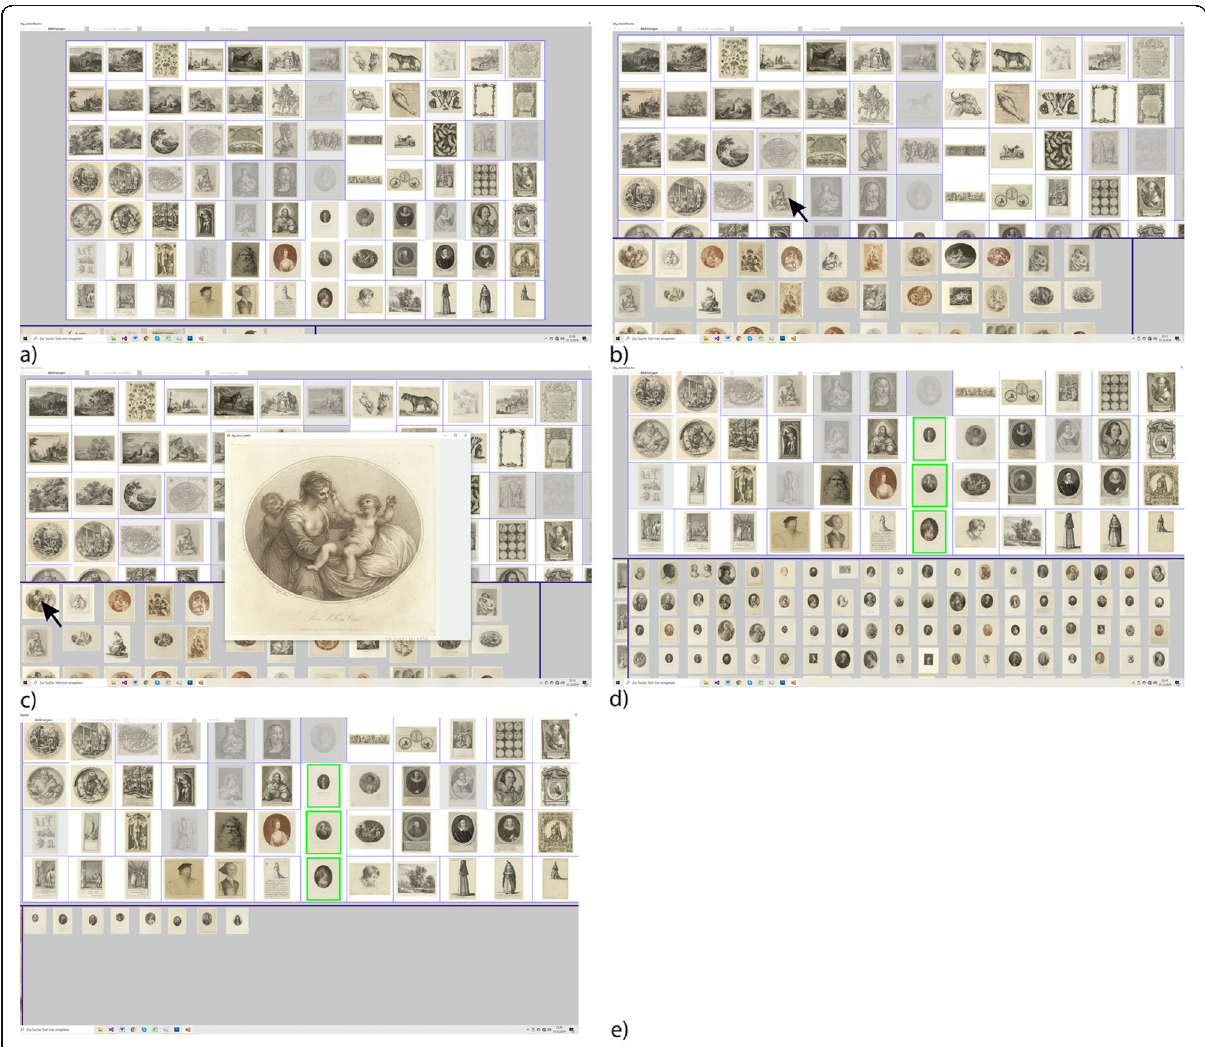
Fig. 17 Screenshots of the interface for the presentation of an image set with a given vocabulary: a Vocabulary view maximized; b The bottom left view shows the images that are most closely related to the word closest to the mouse pointer; c Detailed information on the image nearest to the mouse pointer; d The bottom right view shows the images of the union of the words selected in the vocabulary view; e The bottom right view shows the images of the intersection of the words selected in the vocabulary